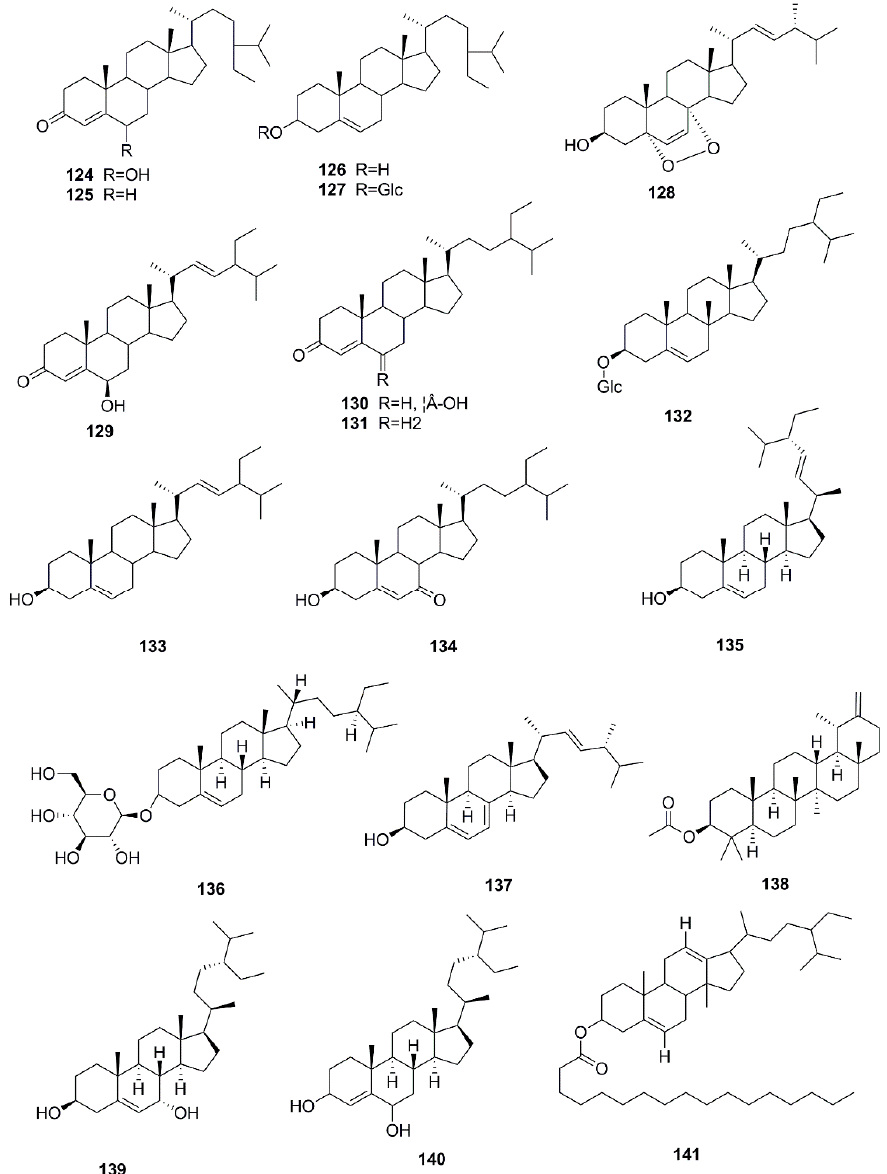
Figure 7. Chemical structures of the steroids in X. strumarium.